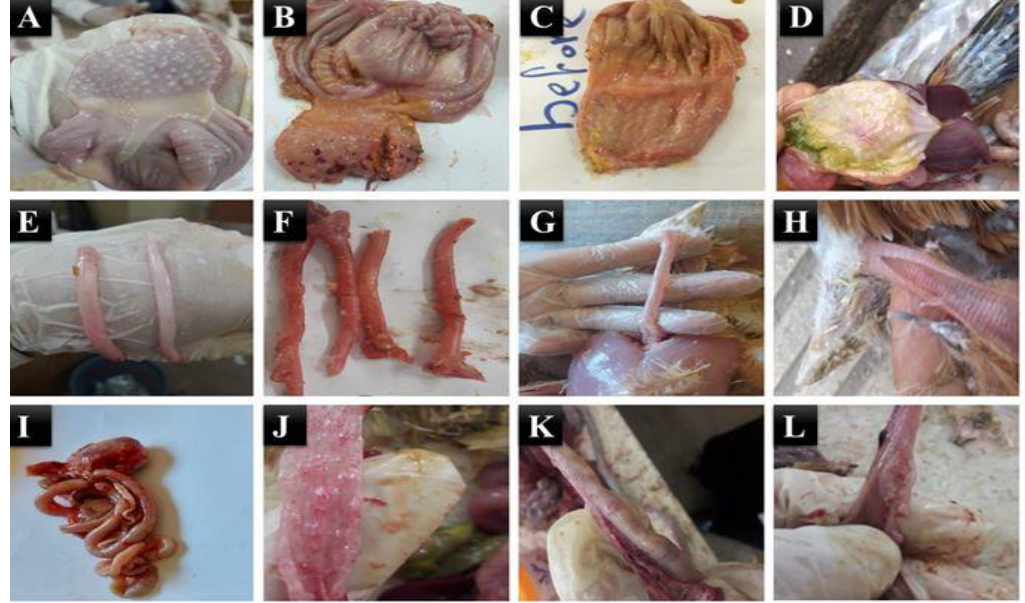
Fig. 4: Effect of ECV extract on post -mortem findings in prophylactic, therapeutic groups and, control groups at 5 dpc and 7 dpc NDv challenge. Comparison in pathological picture of proventriculus A: control group (I) normal anatomical structure and B: control group (II) showed marked petechial hemorrhage at tip of proventricular gland C: group edematous (III) and D: edematous and increased accumulated gland secretions in group IV at 5-day post challenge .